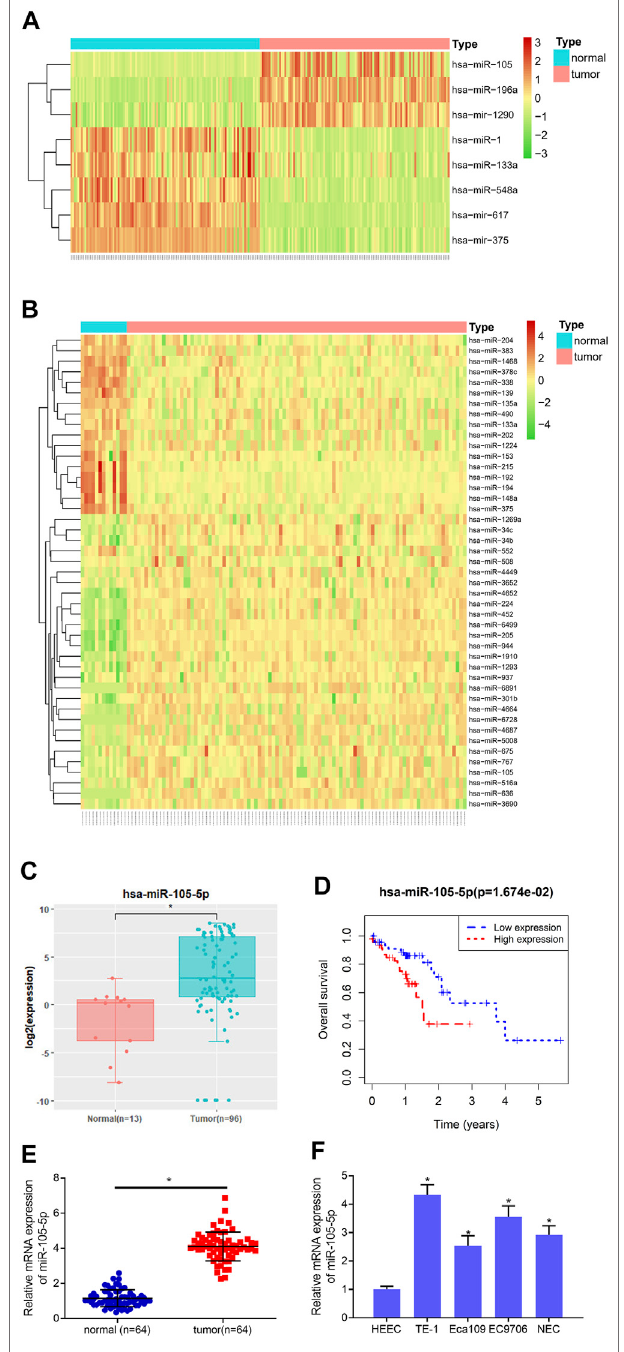
FIGURE 1 | MiRNA-105-5p is activated in ESCC. (A) Heatmap for DEmiRNAs in the GSE55856 miRNA chip; (B) Heatmap for DEmiRNAs in TCGA-ESCCmiRNAdataset; (C) MiRNA-105-5pexpressioninTCGA-ESCC; (D) Survival analysis of miRNA-105-5p expression in TCGA-ESCC dataset; (E) MiRNA-105-5p expression in cancer and adjacent normal tissue; (F) MiRNA-105-5p expression in normal human esophageal epithelial cell line and ESCC cell lines; * p <